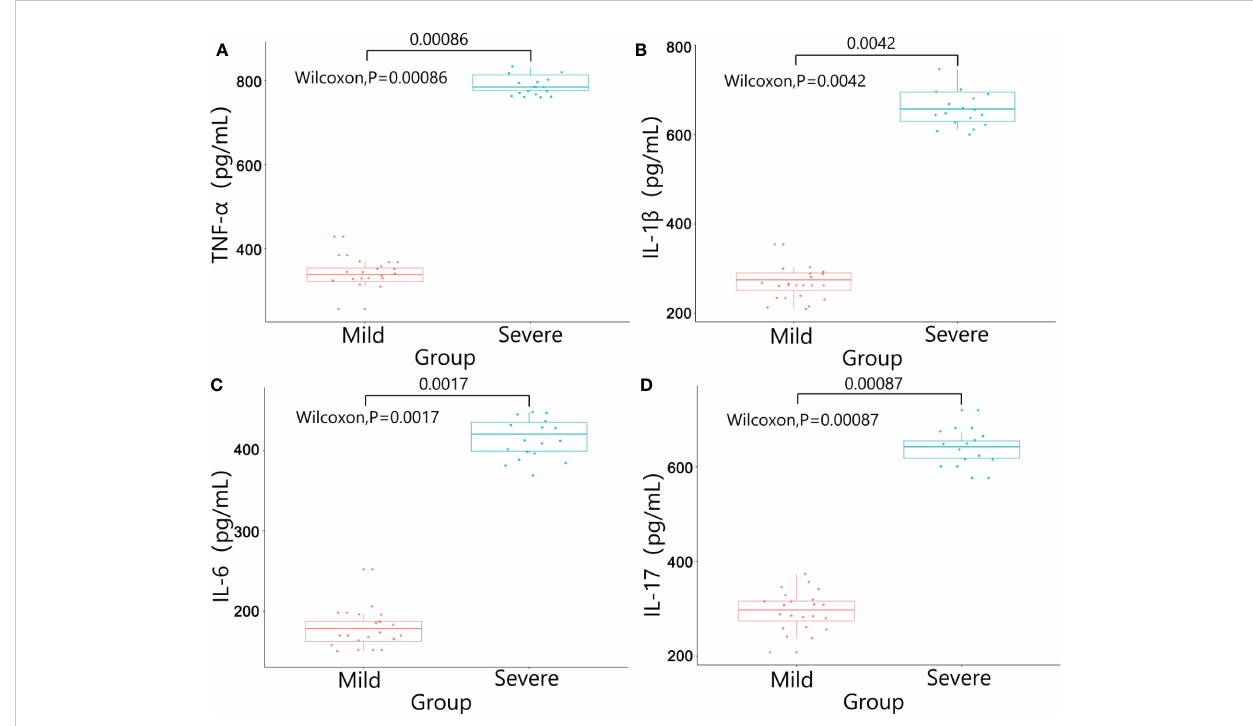
FIGURE 3 Results of in fl ammatory factors in plasma between the two groups. (A) TNF- a ; (B) IL-1 b ; (C) IL-6; (D)